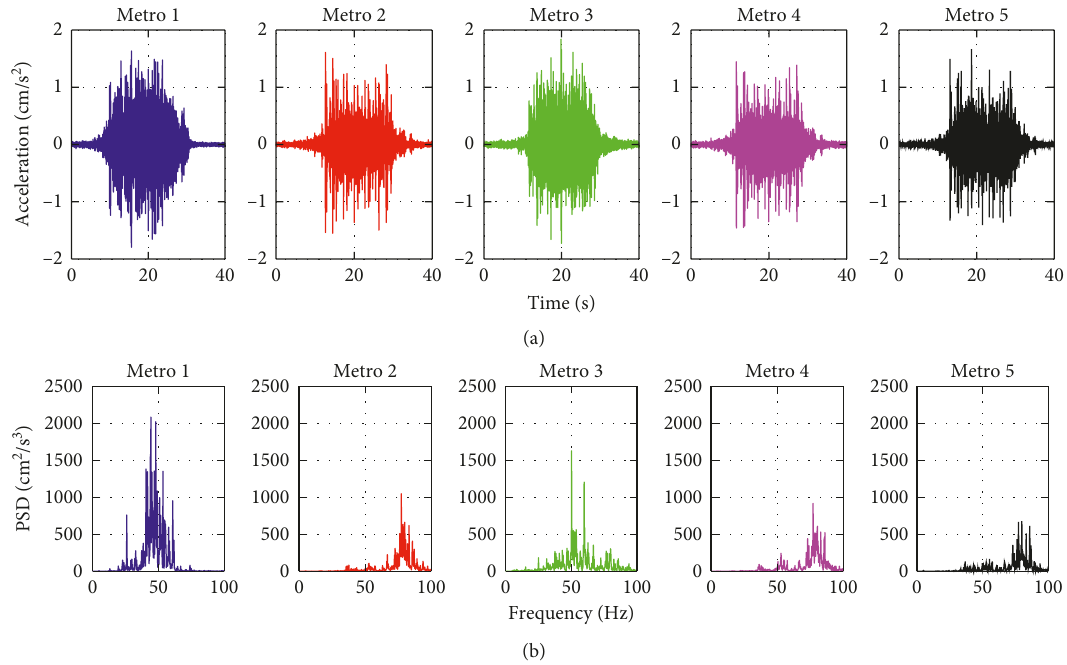
Figure 6: The acceleration signals of measuring point W1 in Z direction. (a) Time-history curves of acceleration. (b) PSD curves of acceleration.